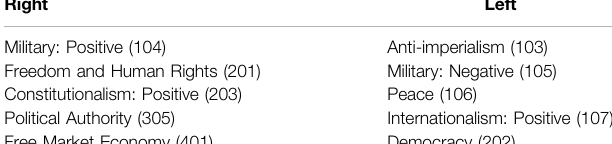
TABLE 4 | Issues used for estimating the RILE index (Budge, 2013). Right Left Military: Positive (104)